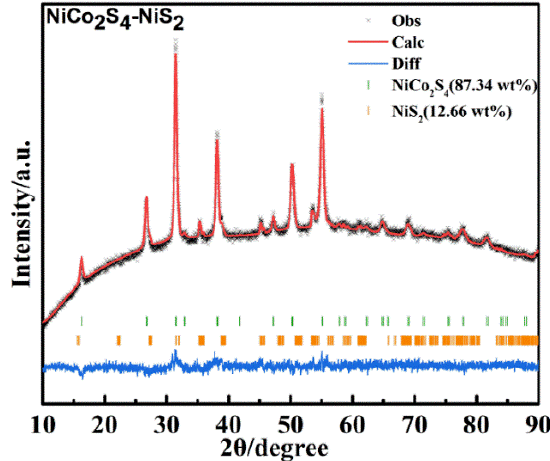
Figure 3. Rietveld refinement of XRD patterns of NiCo 2 S 4 -NiS 2 .